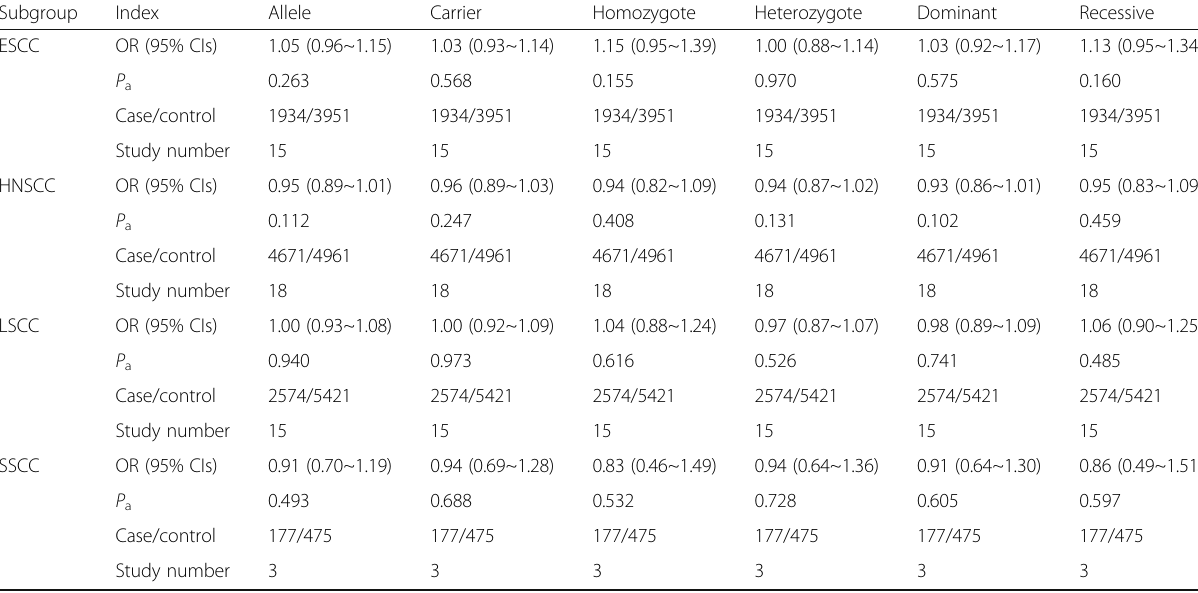
Table 4 Subgroup analysis of the GSTP1 rs1695 A/G polymorphism by SCC type